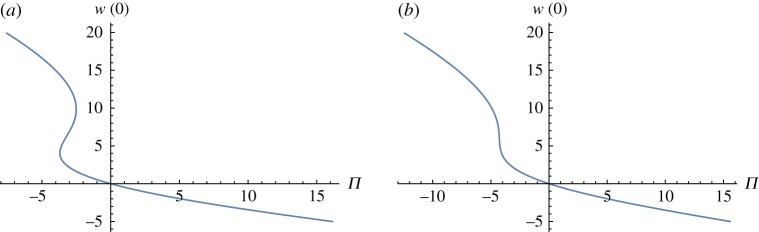
Stationary flows when r = 0.1 and ε increases from 0.06 (a) to 0.1 (b).